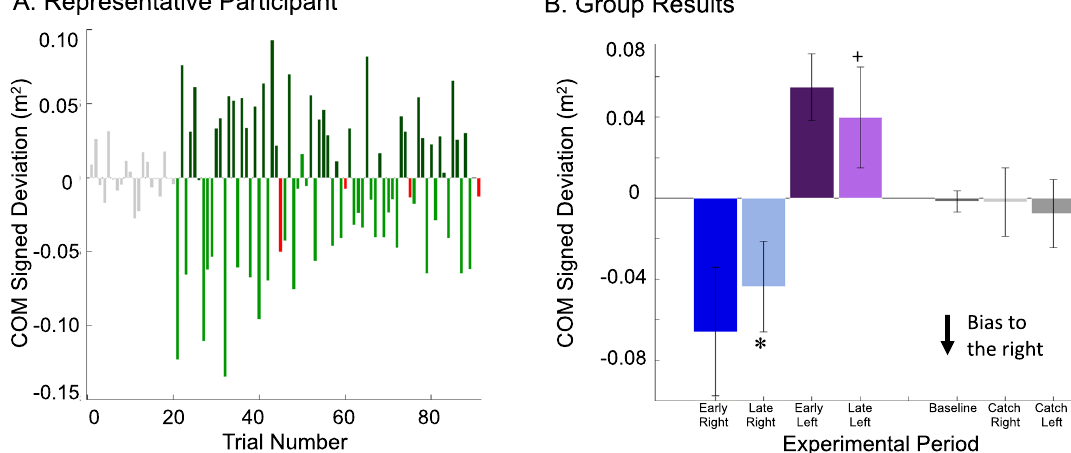
Figure 4. COM signed deviation ( A ) Representative participant and ( B ) Statistical results ( A ) Representative data for a single participant’s COM signed deviation are shown across experimental trial. Grey boxes represent Baseline periods when the force field was off. Light green represents trials when the force field was applied to the right. Dark green represents trials when the force field was applied to the left. Red represents catch trials when the force field was off. ( B ) Mean ± SD for COM signed deviation across experimental period. X-axis labels: ER, EL, LR, LL, B, RC, and LC represent periods early right, early left, late right, late left, baseline, right catch, and left catch, respectively. Significance ( p < 0.05) from early field right is denoted by ( ✽ ) and significance ( p < 0.05) from early field left is denoted by ( +). Outcomes from the two-by-two ANOVA, which analyzed adaptation, identified a significant main effect of experimental period ( p = 0.001) indicating that the magnitude of the COM signed deviation was greater during the early field trials than the late field trials. Outcomes from the one-way ANOVA found no significant main effect of experimental period ( p = 0.267) when comparing baseline, catch right, and catch